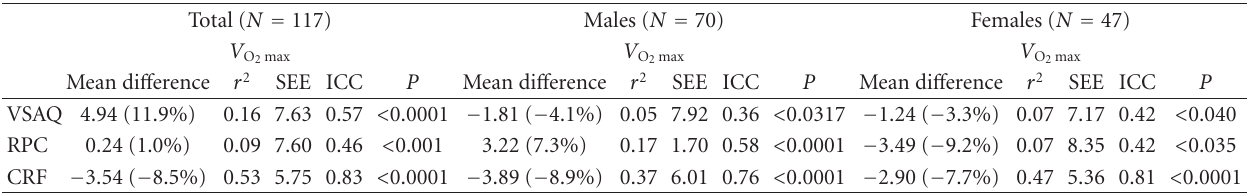
Table 3: Mean di ff erence (mL · kg − 1 · min − 1 ), R -square coe ffi cient, standard error of estimate, and intraclass correlation between V O assessed and estimated by three non-exercise models ( N =